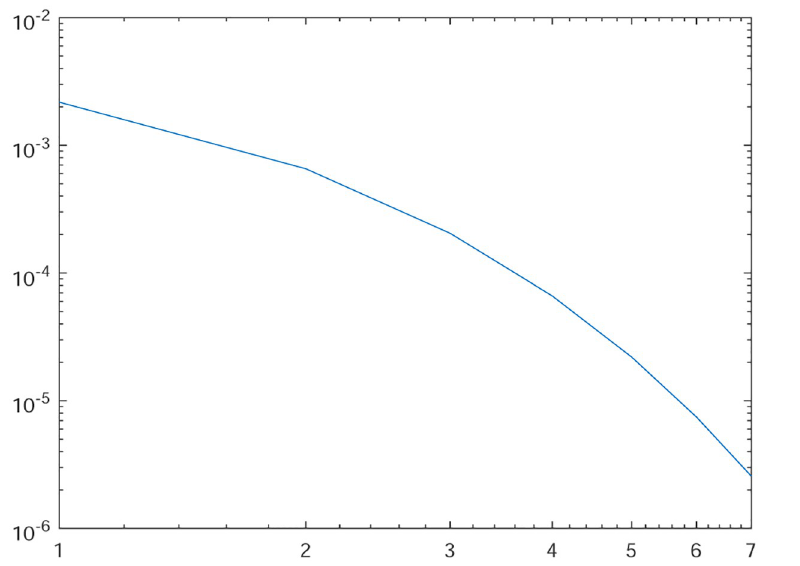
Fig 5. The behavior of the error with respect to the parameter γ for the Experiment 1.